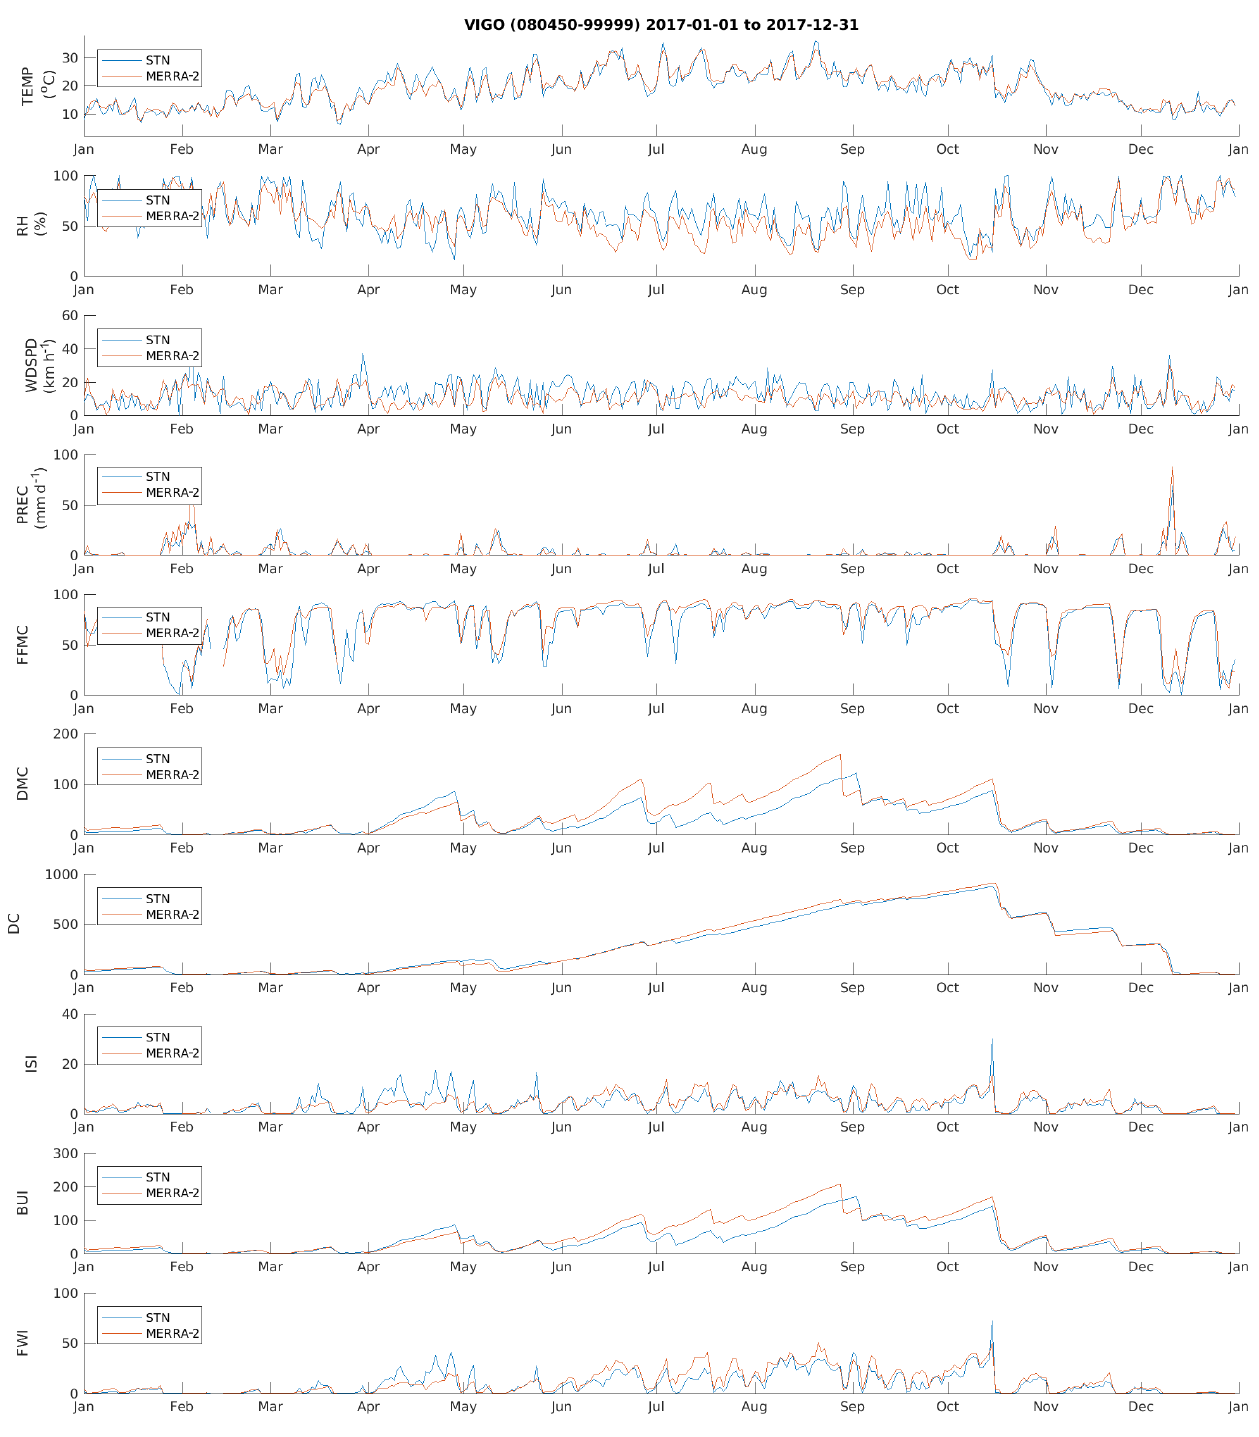
Figure 3. Same as Fig. 2 but for Vigo in northwestern Spain (WMO ID 080450, WBAN 99999; 42.232 ◦ N, 8.627 ◦ W) during 2017.